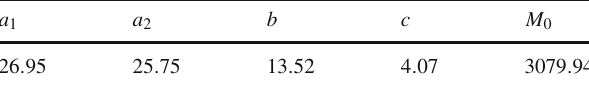
Table 2 Values of the parameters a 1 , a 2 , b , c and M 0 (in MeV), deter- mined from the masses of the (cid:2) c baryons given in [18] and the spin assignments from